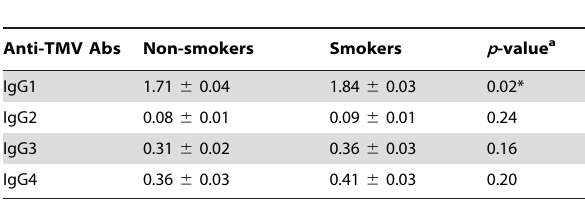
( Figure 2B ). Levels of anti-TMV IgD and anti-TMV IgE were hardly detectable in serum. Only one person (a smoker) showed a high seropositivity (1/20; Figure 2C ); and, approximately, 25%